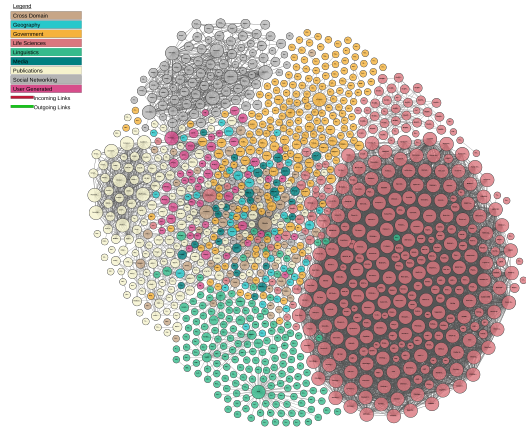
Figure 5. Linking Open Data cloud diagram 2017, by A. Abele,